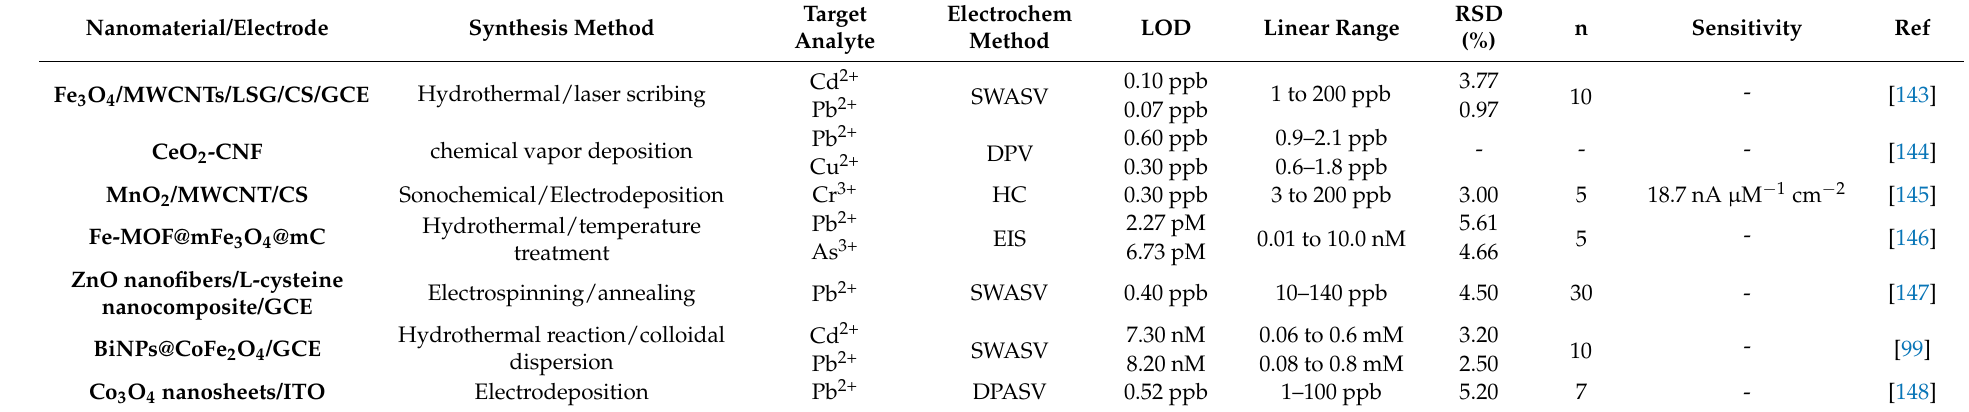
Table 3. Electroanalytical performances of selected transition metal oxide/hydroxide-based nanocomposites as sensors for trace metal detection in water